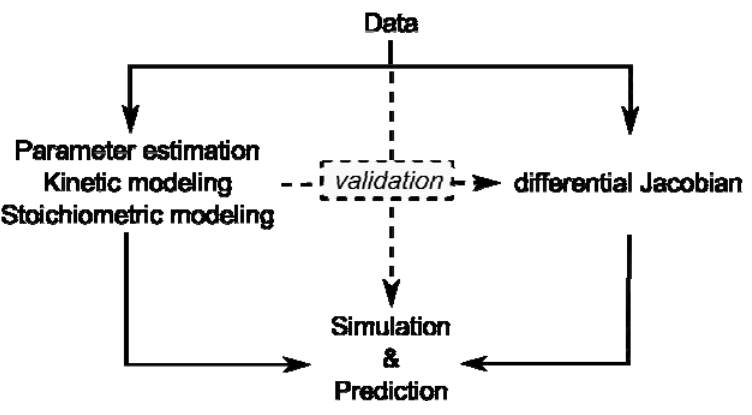
Figure 1. Overview of modeling approaches and their interaction by validation. Data represent results of experiments on the metabolome, proteome, enzyme activities or